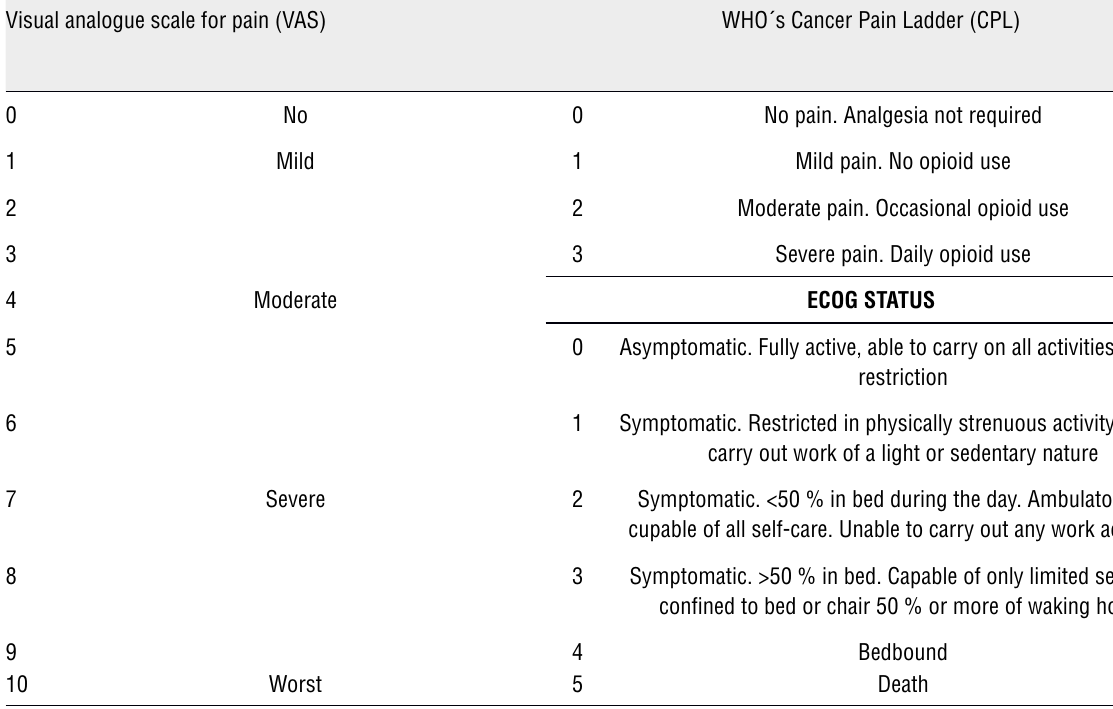
Table 1 - Classification of ECOG, CPL and VAS. Visual analogue scale for pain